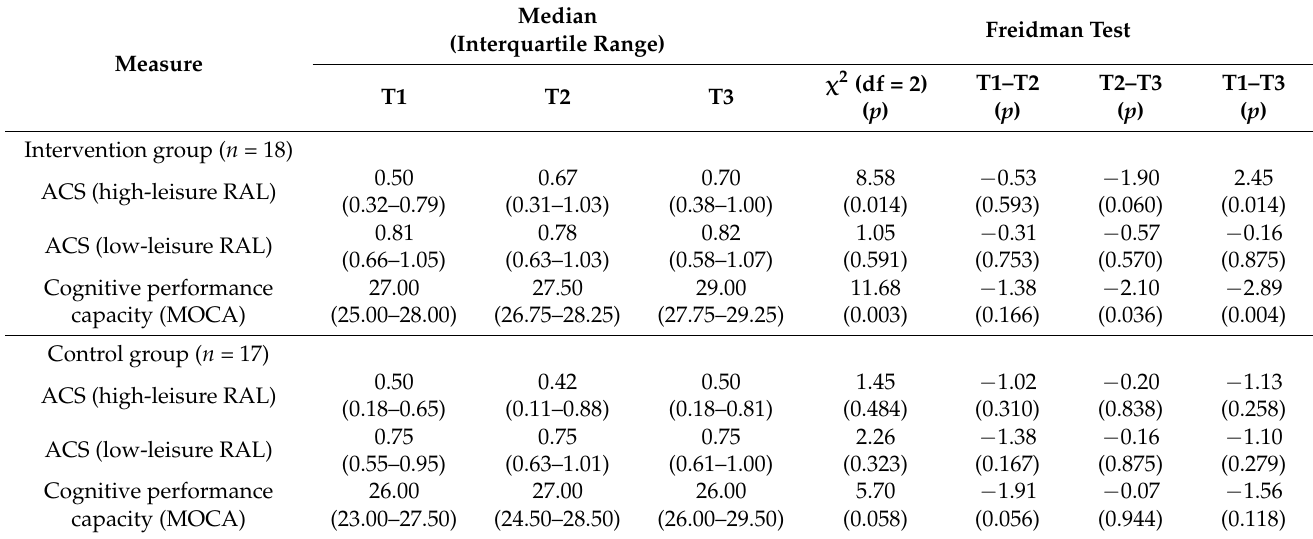
Table 3. Descriptive statistics and results of within-nonparametric group